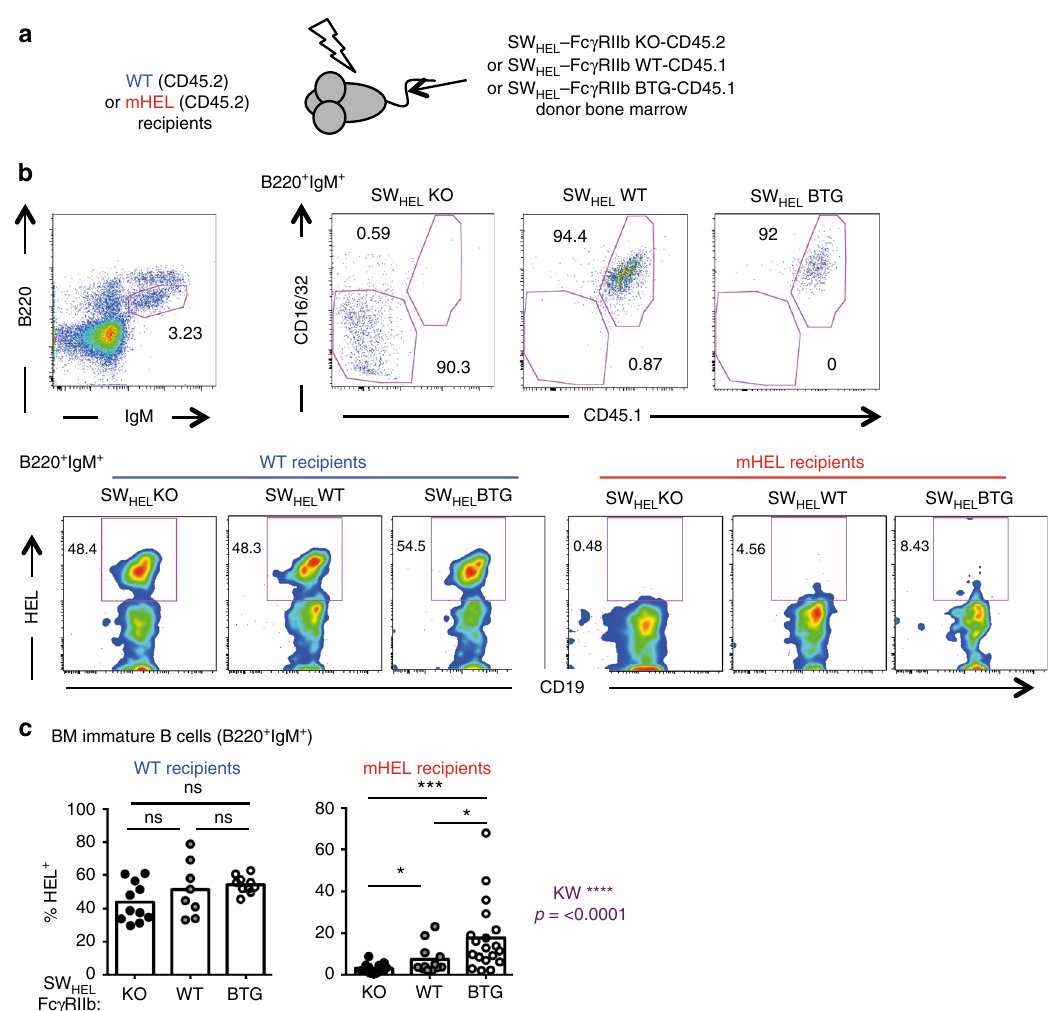
Fig. 1 Reduced Fc γ RIIb expression increases central tolerance. a Experimental procedure: wild-type and mHEL recipients (both CD45.2) were lethally irradiated and reconstituted with bone marrow from SW HEL -Fc γ RIIb KO-CD45.2, SW HEL -Fc γ RIIb WT-CD45.1 or SW HEL -Fc γ RIIb BTG-CD45.1 donor mice. b Representative fl ow plots of immature B cells in the bone marrow (B220 + IgM + , left top panel). B cells originating from the donor bone marrow were identi fi ed based on Fc γ RIIb expression (detected with an anti-CD16/32 Ab) and expression of the congenic marker CD45.1 (right top panels). The frequency of HEL-speci fi c cells for each condition is showed using the smoothing function to help the visualisation of rare events (bottom panels). c Quanti fi cation of the frequency of HEL-speci fi c immature B cells in WT (left panel) and mHEL (right panel) recipient mice. mHEL recipients: n = 12 – 19 mice per group; wt recipients: n = 8 – 11 mice per group. The mean is represented and each dot corresponds to an individual mouse. Four pooled experiments are shown. The p -values were determined with the Kruskal – Wallis (KW) non-parametric test when comparing the three groups (KW: the p - value is indicated in purple for the mHEL recipient. All KW tests were not signi fi cant for WT recipients) and with the Mann – Whitney non-parametric test when two conditions were compared (indicated by black stars). * p < 0.05; ** p < 0.01; *** p < 0.001. Comparisons generating non-signi fi cant p -values are indicated with “ ns ” . Source data are provided as a Source Data fi